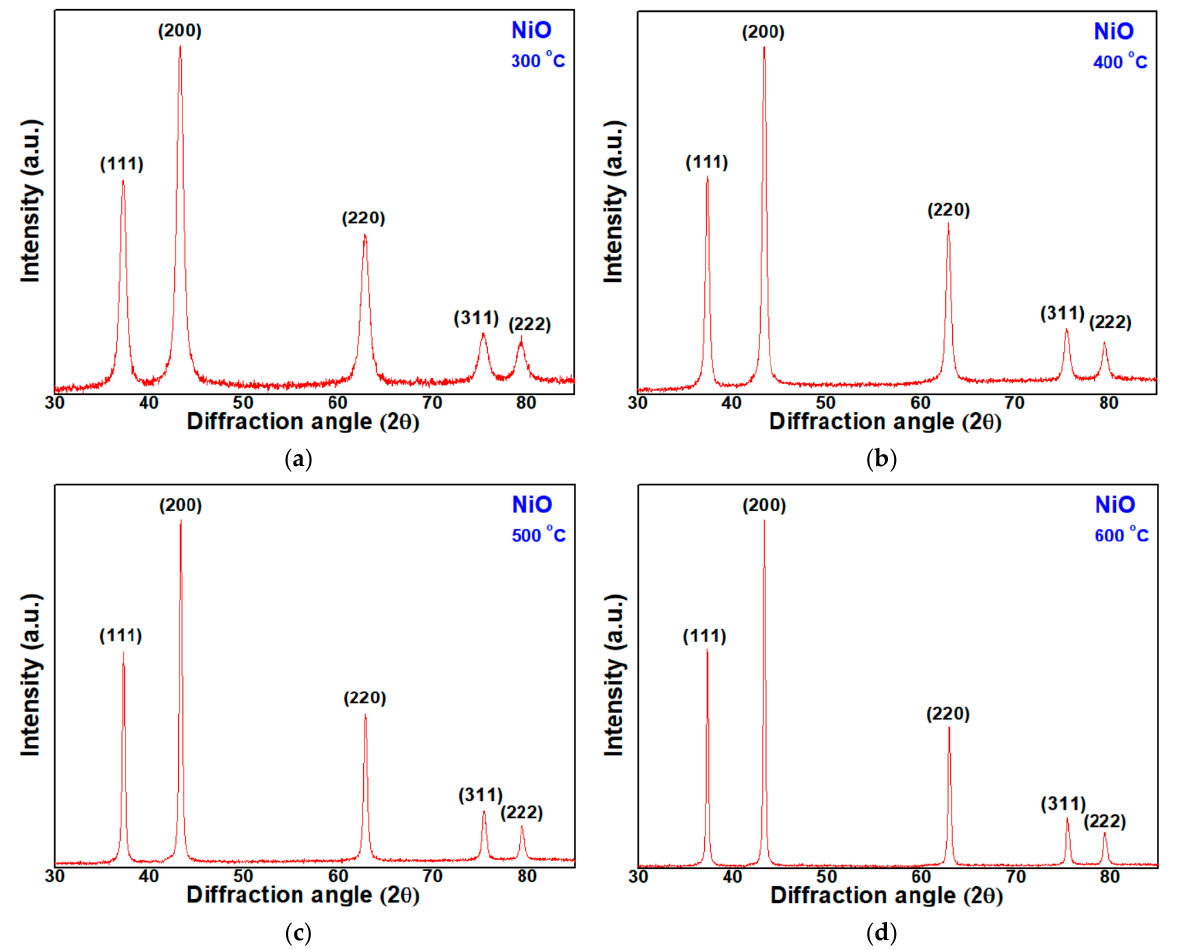
Figure 3. XRD patterns of NiO NPs heat-treated at ( a ) 300 °C; ( b ) 400 °C; ( c ) 500 °C; ( d ) 600 °C.